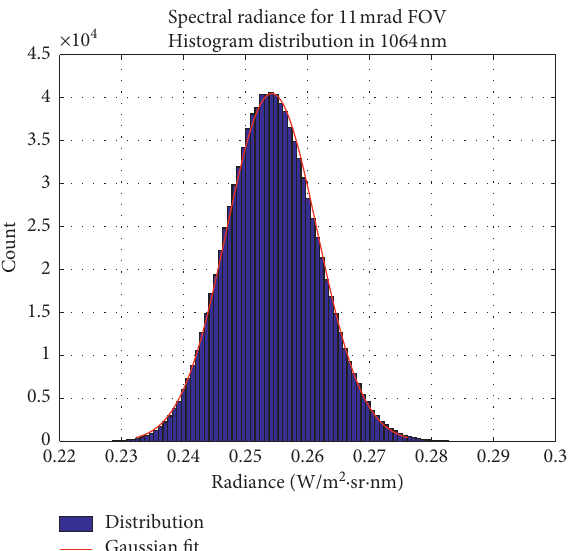
Figure 5: Plot showing 1064nm spectral radiance histogram distribution and associated Gaussian fit function. The mean value of the function is the spectral radiance value 0.25424 (Wm − 2 · sr − 1 · nm − 1 ), and one sigma value of it is 0.007315 (Wm − 2 · sr − 1 · nm − 1